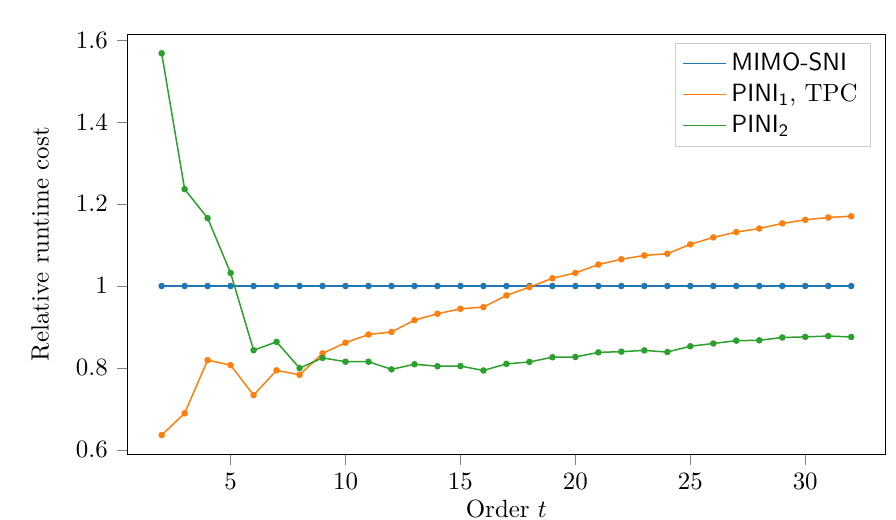
Figure 2: Software runtime cost for a bitslice, masked and composable AES S-box implementation. The cost is measured relatively to the cost of the optimized MIMO-SNI S-box in [CS18]. The curves for PINI 1 and TPC (S-box implementation with only ISW multiplications and no refresh elements, proven secure in [BGR18]) are indistinguishable at the scale of this plot. The source code for this plot is available from